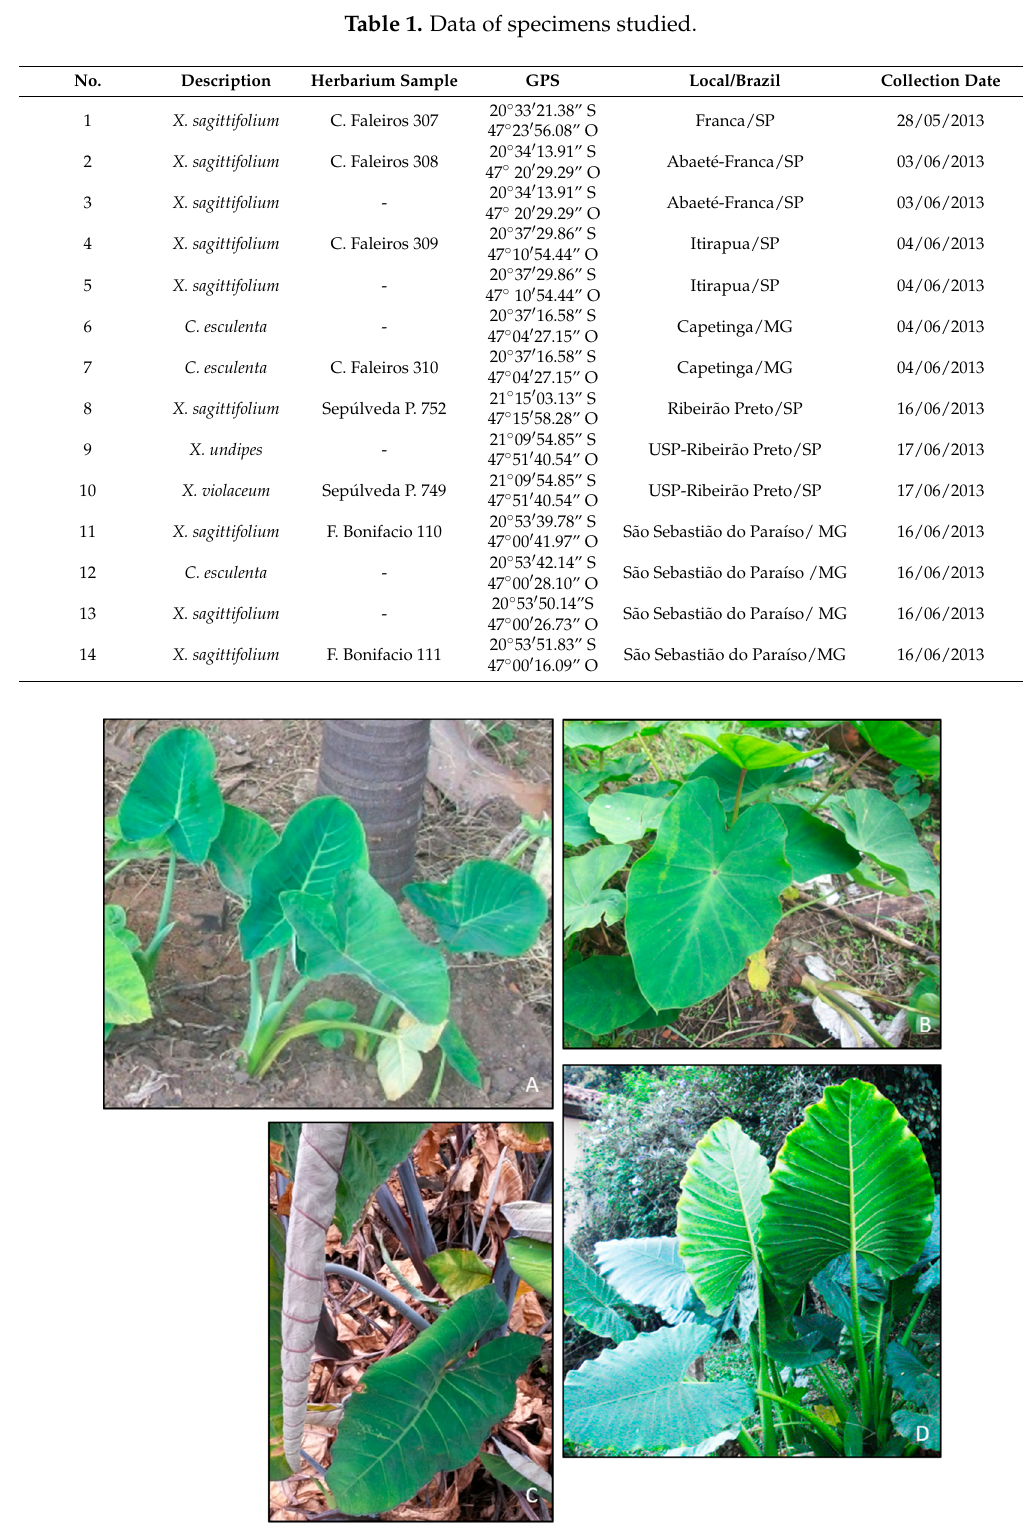
Table 1. Data of specimens studied.